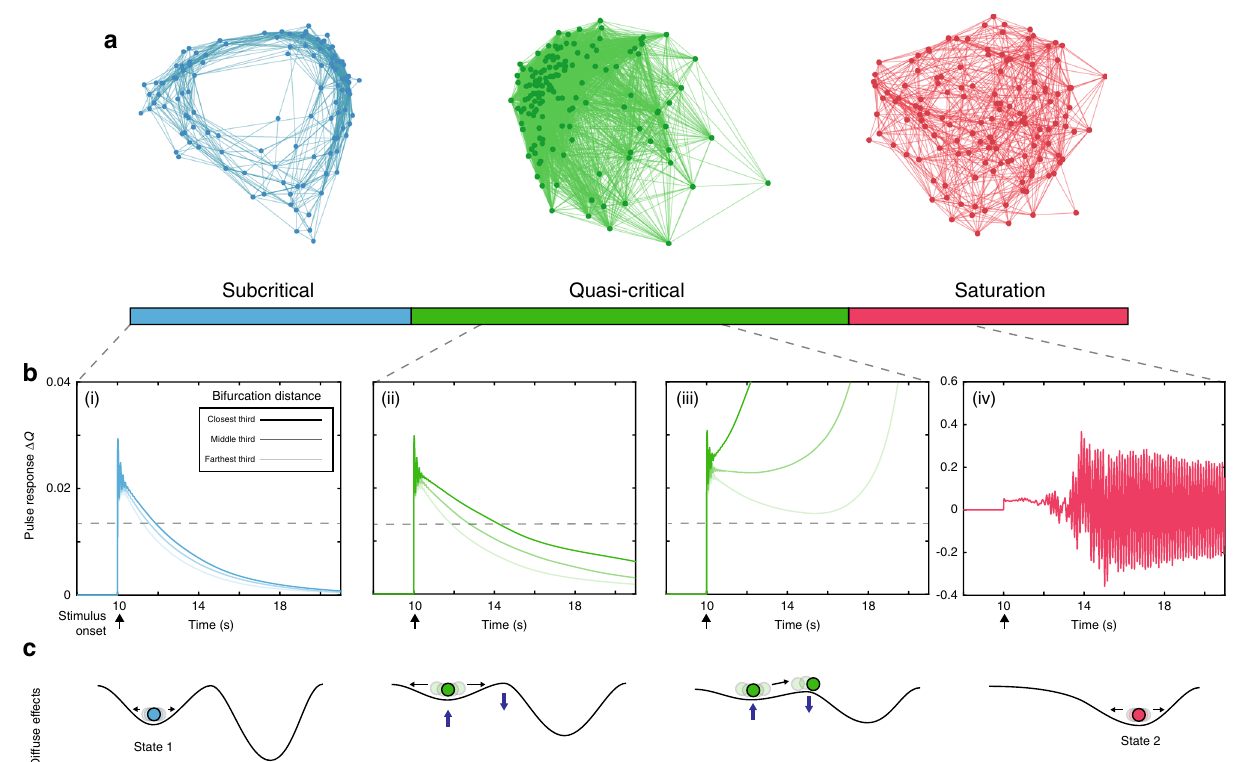
Fig. 3 Properties of quasi-critical states. a Average regional correlations within each zone shown as a force-directed graph. b For a given χ , each node was stimulated with an excitatory rectangular pulse (amplitude = 1 mV; width = 10 ms) at t = 10 s. The target nodes activity was then compared to simulated activity in the absence of the pulse using the same noise sequence in order to quantify the perturbation induced. The pulse results are sorted based on their mean distance to bifurcation in the preceding 8 time points. For visualization purposes we then average the activity within the closest, middle, and farthest thirds based on this sorted distance, and low-pass fi ltered with a passband frequency of 0.001 Hz. (i) χ = 1.15 × 10 − 4 (ii) χ = 1.21 × 10 − 4 (iii) χ = 1.25 × 10 − 4 (iv) χ = 1.3 × 10 − 4 mV s; Note the vertical axis on (iv) differs from (i) – (iii). c Qualitative effect of increasing diffuse coupling on the attractor landscape: in the subcritical zone, the system was enslaved to the lower attractor; increasing χ into the quasi-critical zone had the effect of fl attening the attractor landscape, allowing noise-driven excursions to transition nodes across their local bifurcation point; at high values of χ , the system became enslaved to the higher attractor.